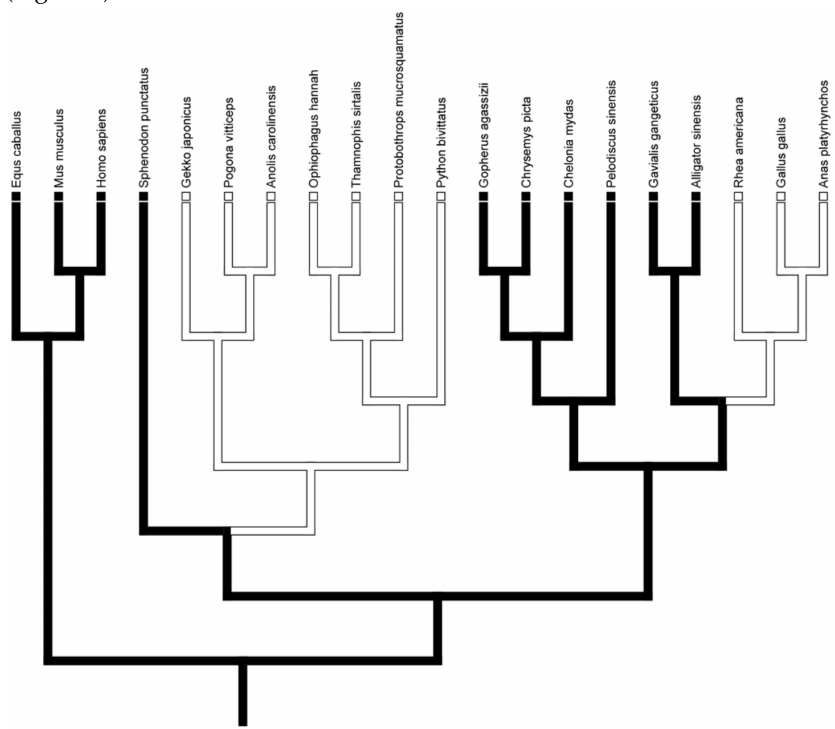
Figure 1. The character optimization of TLR 8. All optimization algorithms yielded an unequivocal inference for TLR 8 genes; the basal diapsid possessed TLR 8, but it was subsequently lost in Lepidosauria and